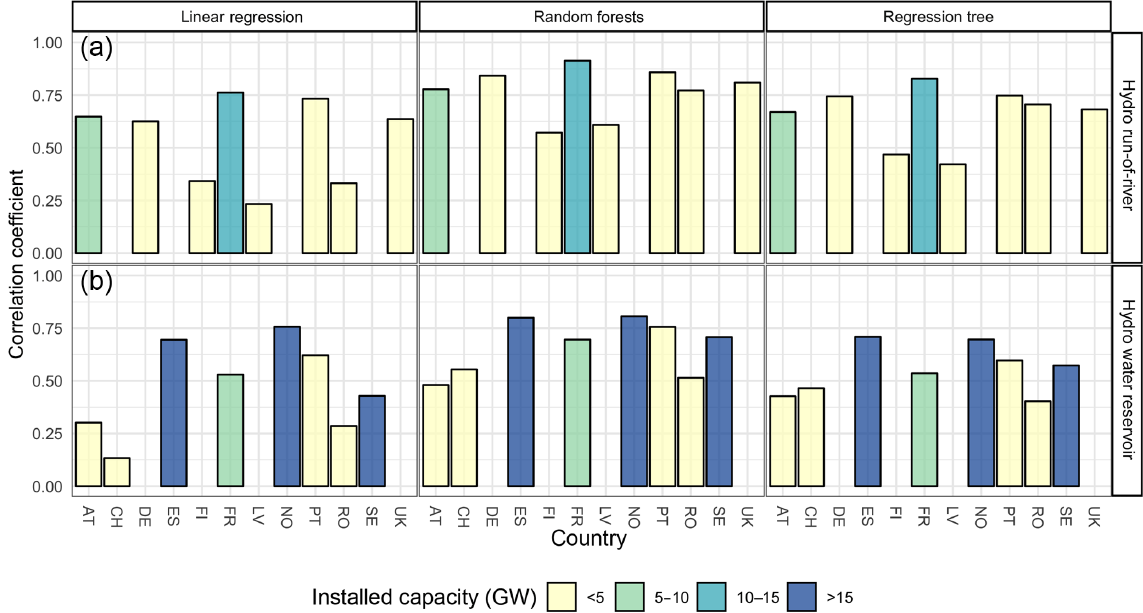
Figure 4. Correlation between prediction of country-average hydro power capacity factor using three statistical models (linear regression, random forests, regression tree) and measured data from the ENTSO-E dataset. (a) Run-of-River production. (b) Water Reservoir production. Country abbreviations are (in the order given): Austria (AT), Switzerland (CH), Germany (DE), Spain (ES), Finland (FI), France (FR), Latvia (LV), Norway (NO), Portugal (PT), Romania (RO), Sweden (SE), United Kingdom